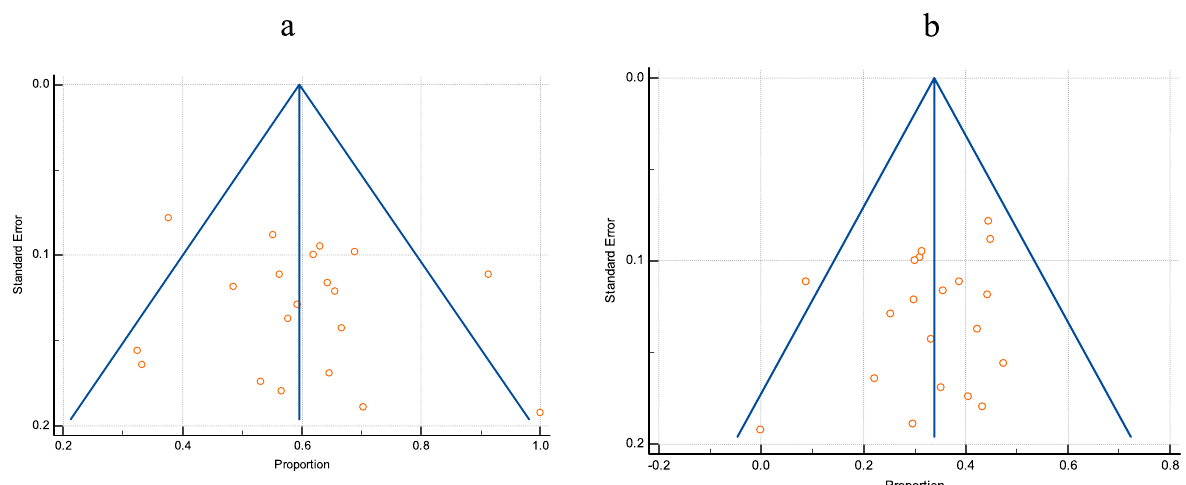
Fig. 4 Funnel plot of publication bias for E. faecalis and E. faecium among total enterococci isolates. a Funnel plot of E. faecalis among total enterococci. b Funnel plot of E. faecium among total